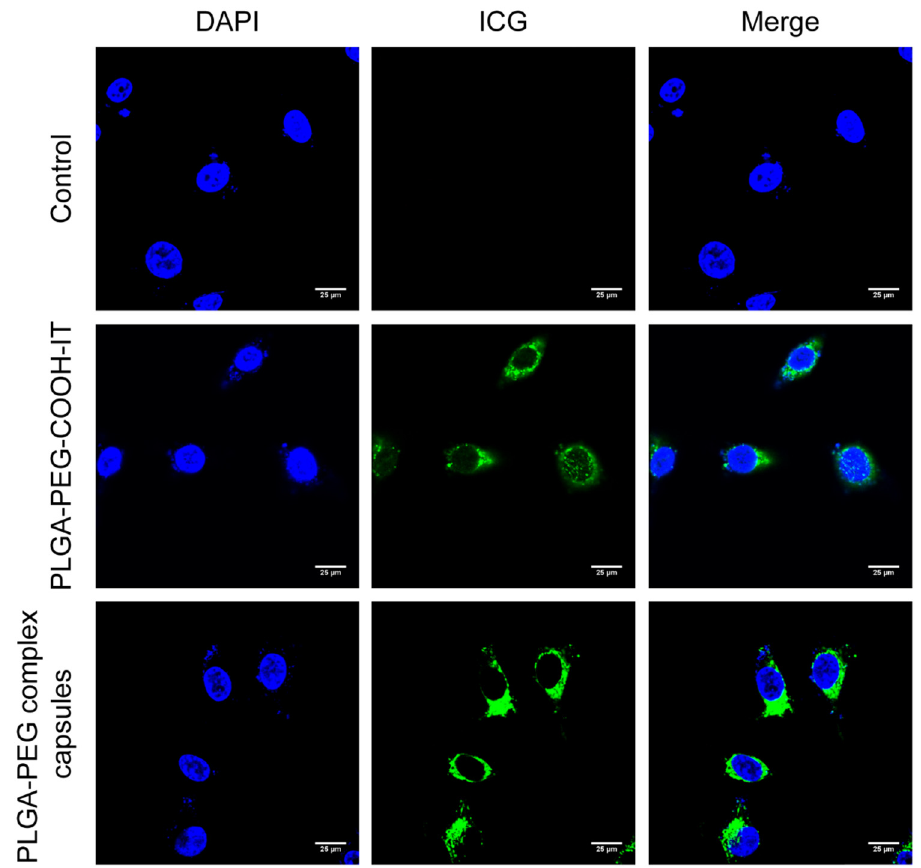
Figure 3: In vitro cellular internalization evaluation of PLGA - PEG - COOH - IT and PLGA - PEG complex capsules incubated with SH - SY5Y/IR cells for 6 h by fl uorescence microscope ( blue: cell nuclei; green: ICG; scale: 25 μ m, n = 3 )